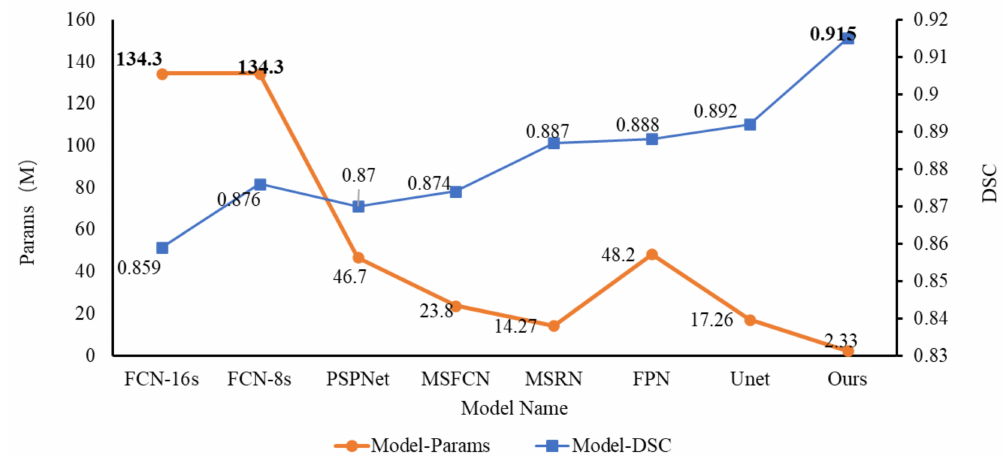
Figure 10. The DSC for different models and parameter scale for this model.